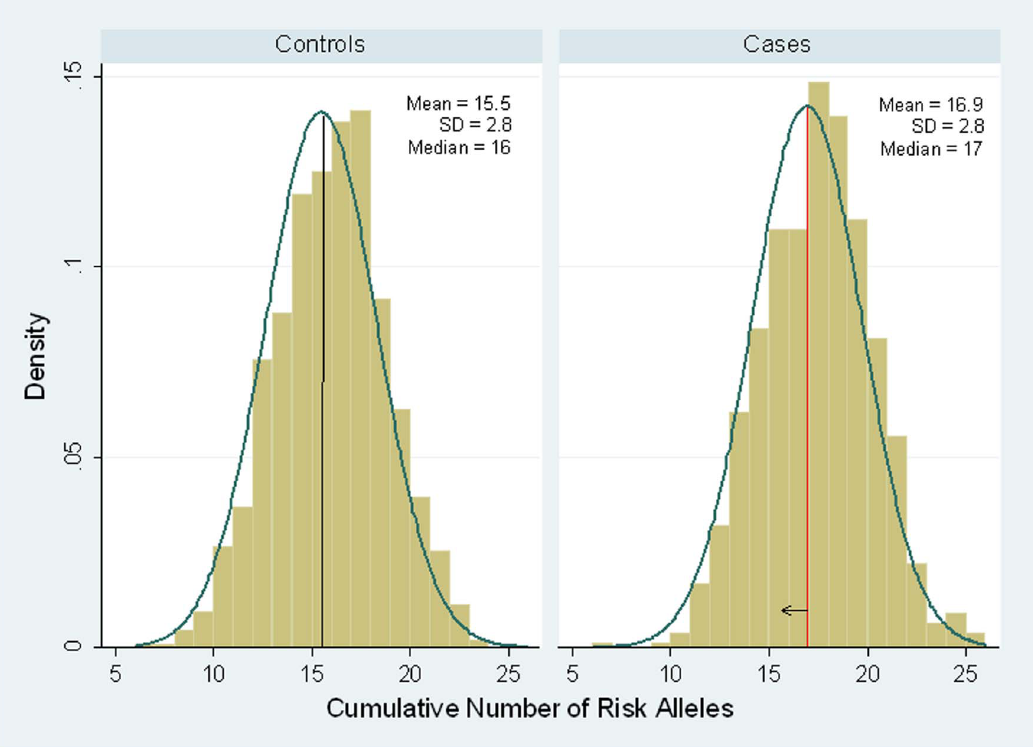
Figure 1. Distribution of the cumulative number of risk alleles among prostate cancer cases and control subjects. Solid lines represent the median number of risk alleles in controls (black line) and cases (red line). The arrow shows the shift in median number of risk alleles between cases and controls. Abbreviation, SD: standard deviation.